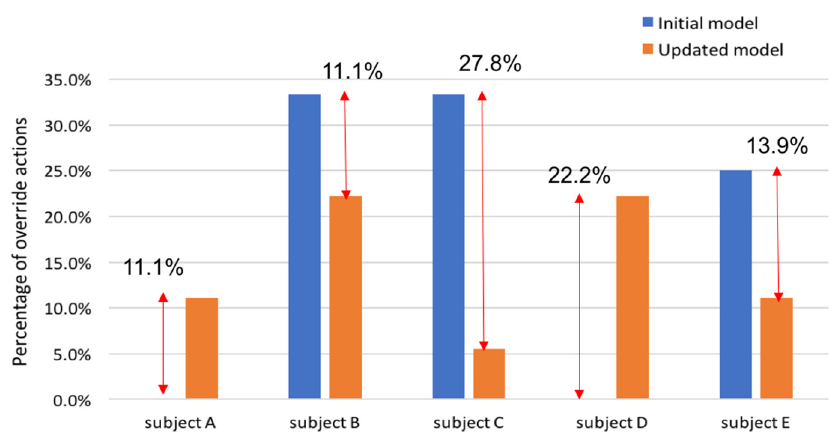
Figure 12. The comparison between initial and updated thermal comfort models.